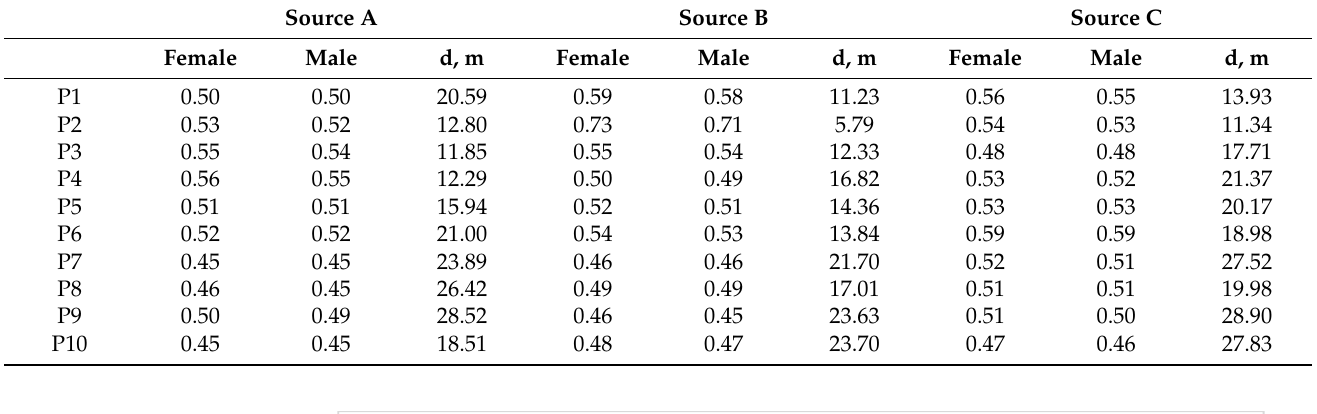
Table 9. STI values for source/receiver combinations.